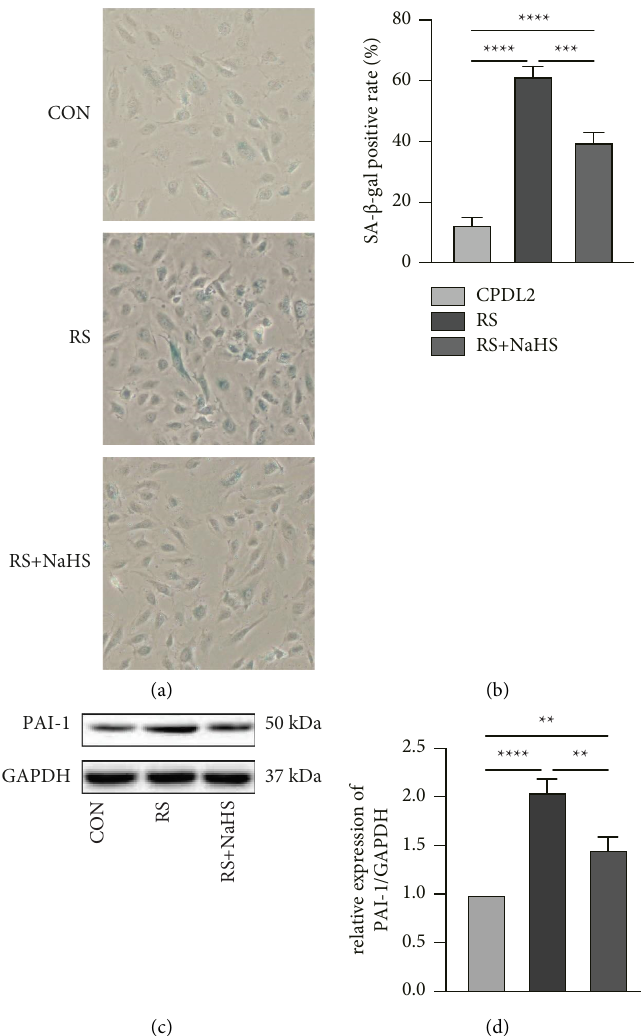
Figure 6: Impact of NaHS on replicative senescence of HUVECs. SA- β -Gal staining (a) and the statistics (b) of HUVECs in each group (100 × ). Senescent cells were stained blue. n � 3 per group. ∗∗∗ P < 0 . 001, ∗∗∗∗ P < 0 . 0001 by LSD-t test after ANOVA. Te expression of PAI-1 of HUVECs in diferent groups as detected by western blot (c) and its statistics (d) n � 3 per group. ∗∗ P < 0 . 01, ∗∗∗∗ P < 0 . 0001 as examined by LSD-t test after ANOVA. CON: control group, HUVECs at CPDL2; RS: replicative senescence group, HUVECs at CPDL16; RS+NaHS: HUVECs at CPDL16 and exposed to 200 μ mol/L NaHS for 24